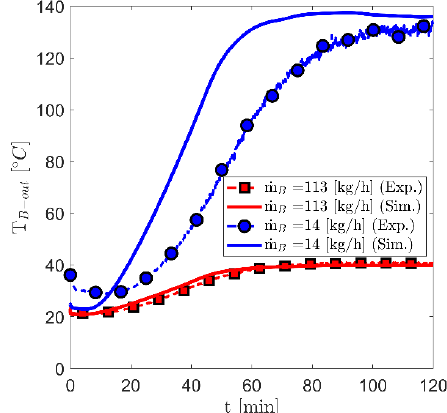
Figure 5. Transient characteristics of the bypass outlet temperature (T B − out ). The results under steady state conditions show the well-known relationship of in- creasing mass flow rates with simultaneously decreasing outlet temperatures in both the measurement and simulation characteristics. Related to the experimental data, slightly higher steady-state active cooling powers of 570 W result here at a mass flow of 113 kg/h compared to 420 W at a mass flow of 14 kg/h. Similar orders of magnitude with 540 W and 440 W are also reached in the simulative results. These effects are caused by increas- ingly convective heat transfer coefficients associated with higher mass flow rates. In ad- dition to comparable steady-state results, the transient characteristics between the exper- imental and simulative temperatures also show a good agreement. Larger deviations can be seen especially at low mass flow rates, which can be explained by the neglection of the thermal mass of the bypath channel inside the model. Analogous to the exemplarily presented contexts, all results within the conducted measurement campaign for active cooling show comparably characteristics with good agreements between experiment and simulation. The resulting central steady-state results based on the investigations according to Table 2 are summarized in Figure 6. Figure 6. steady-state bypass temperature differences between outlet ( T (cid:3003)(cid:2879)(cid:3042)(cid:3048)(cid:3047) ) and inlet ( T (cid:3003)(cid:2879)(cid:3036)(cid:3041) ) as a function of average inventory temperatures ( T(cid:3365) (cid:3010) )—experimental results illustrated with symbols, simulative results with lines.